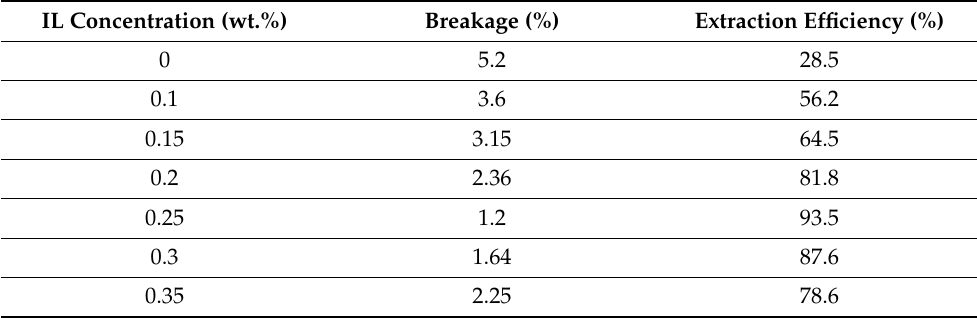
Table 3. Breakage and extraction efficiency for Ibf recovery at various IL concentrations. IL Concentration